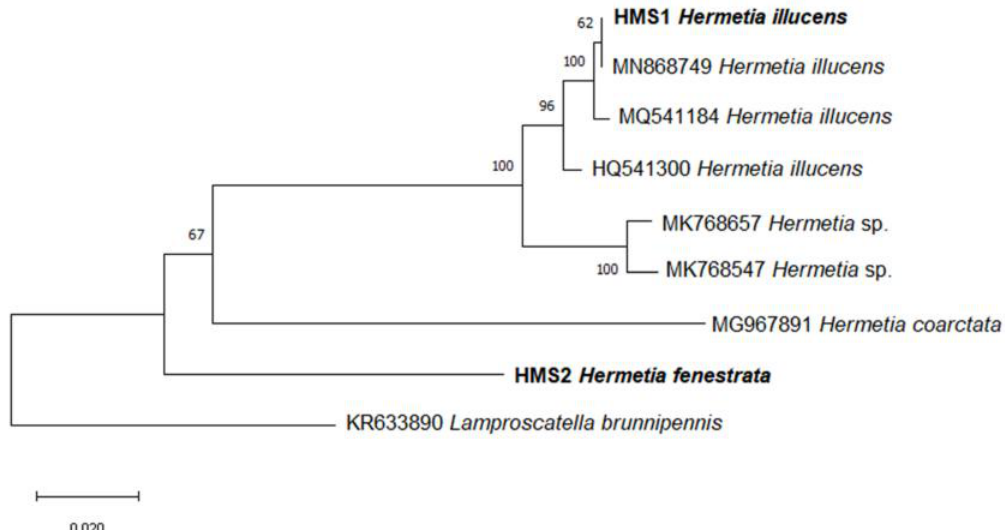
Figure 9. Neighbor-Joining tree of Hermetia taxa based on COI sequences. Bootstrap values are shown on the branches. The scale bar represents 0.020 substitutions per nucleotide position. Sequences generated from the present study are in